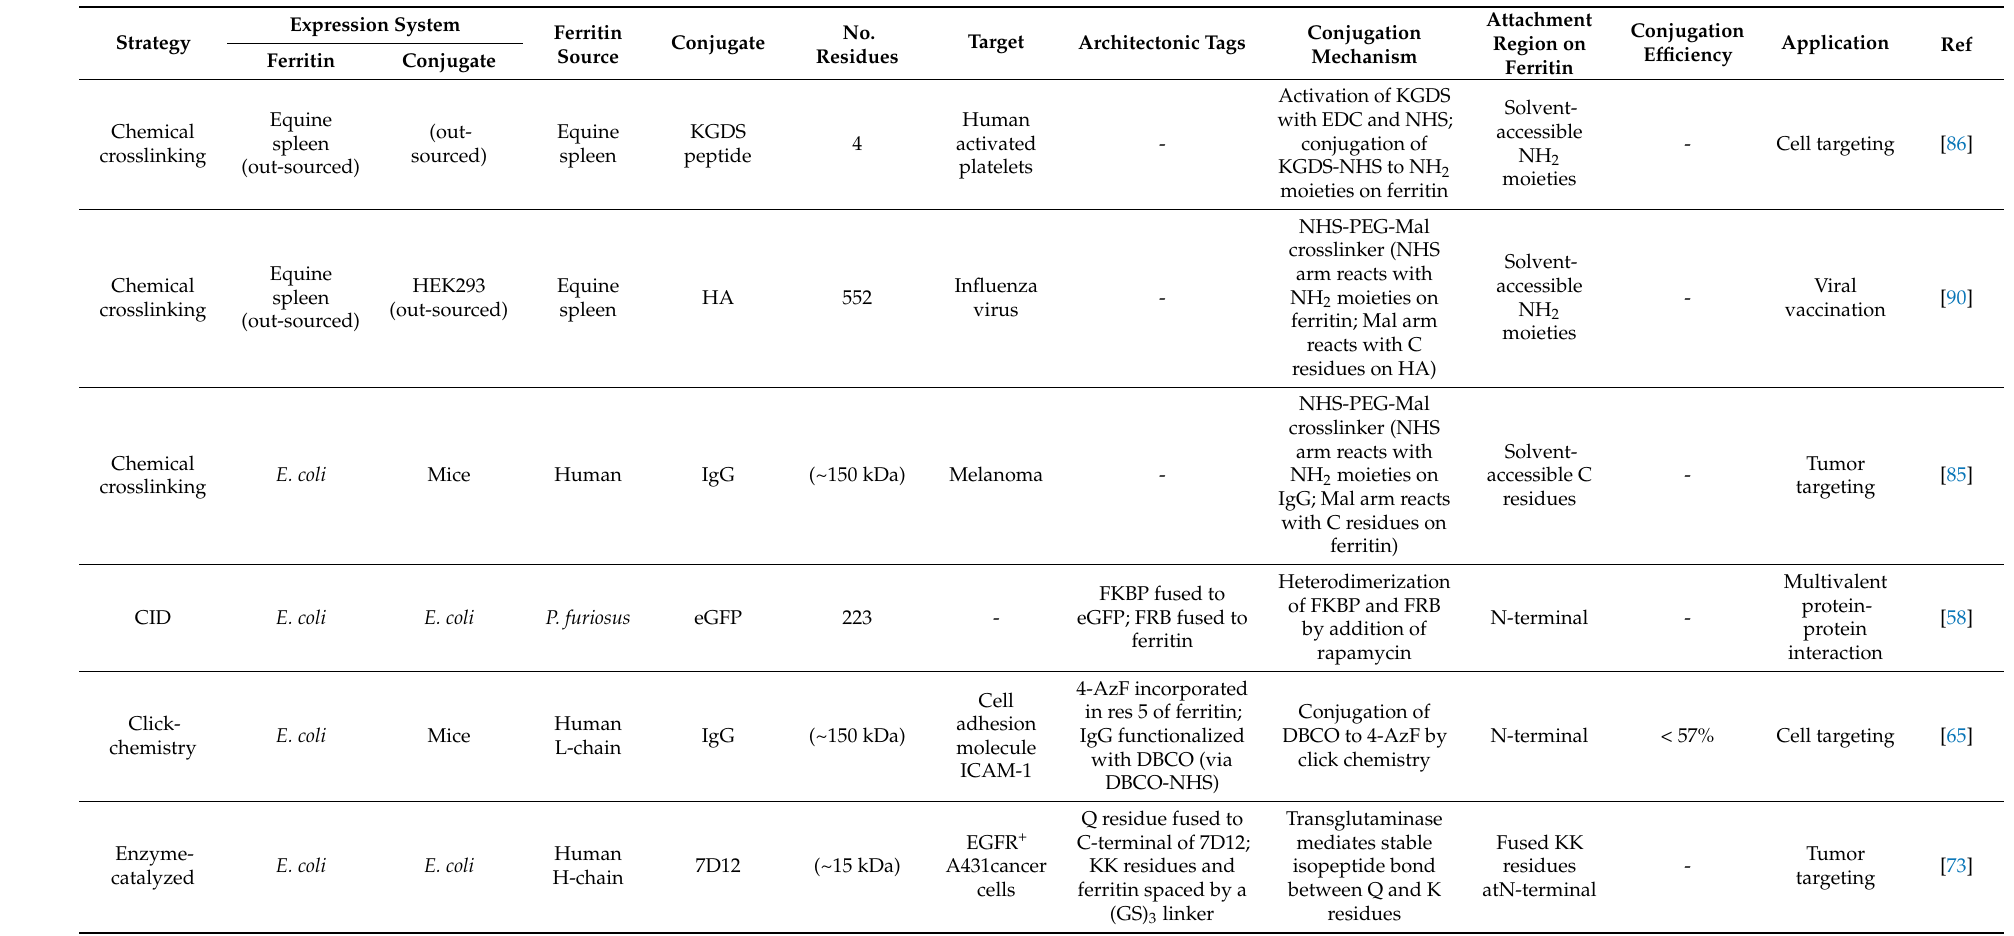
Table 3. Surface functionalization of ferritin nanoparticles by the modular assembly for antigen-display